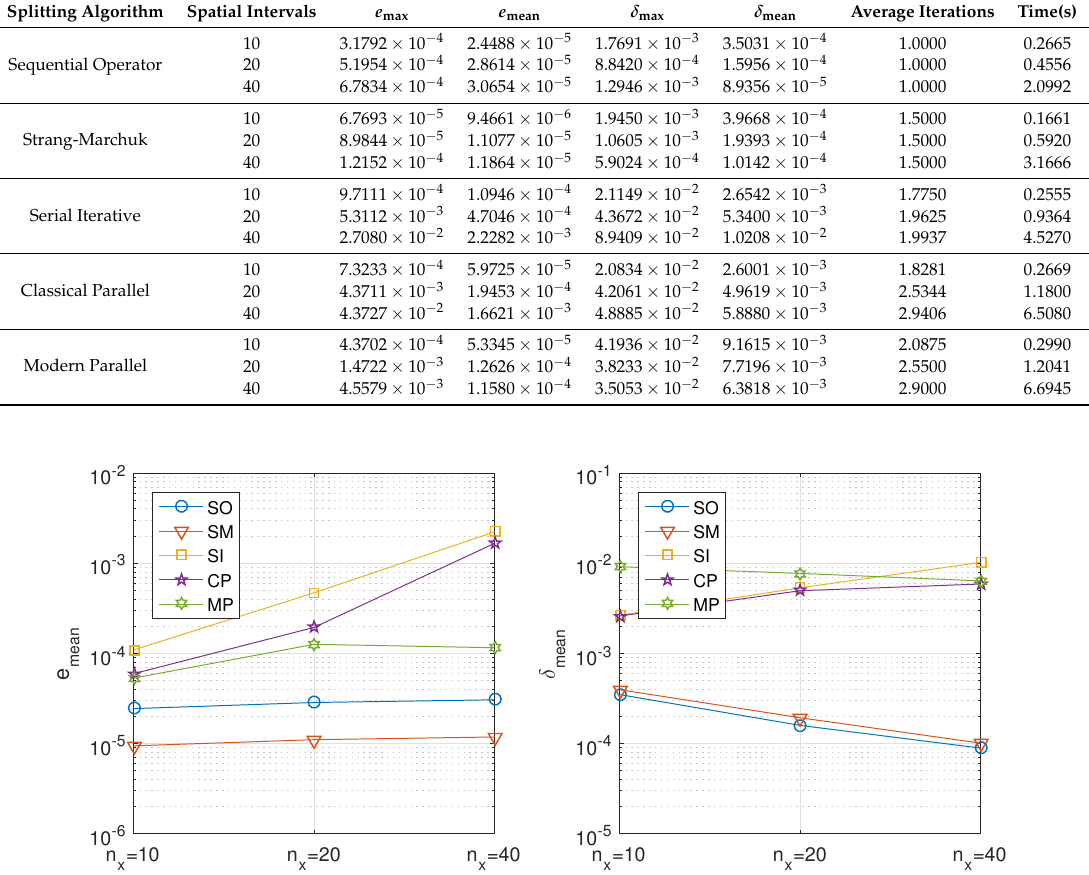
Figure 16. Fractional diffusion equation, directional decomposition. Precision of the proposed methods: sequential iterative SI, classical parallel CP, and modern parallel MP, compared with the classical ones: sequential operator SO and Strang–Marchuk SM, for 320 temporal steps and different number of spatial